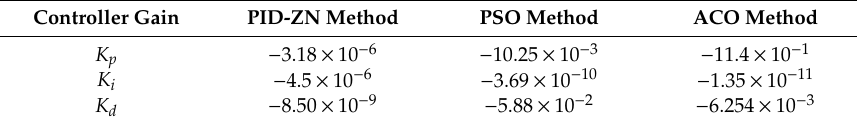
Table 3. K p , K i and K d parameters of Ziegler–Nichols (ZN), PSO, and ACO.